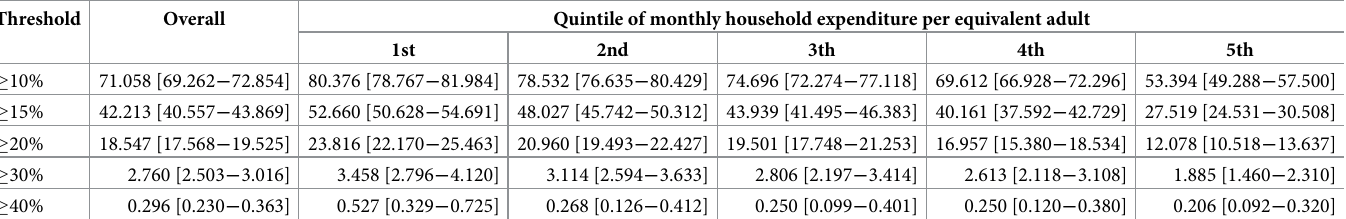
Table 5. Adjusted share of OOPE on medicines out-off household’s capacity to pay according to quintile of household expenditure. HIES, Bangladesh, 2016/17. Threshold